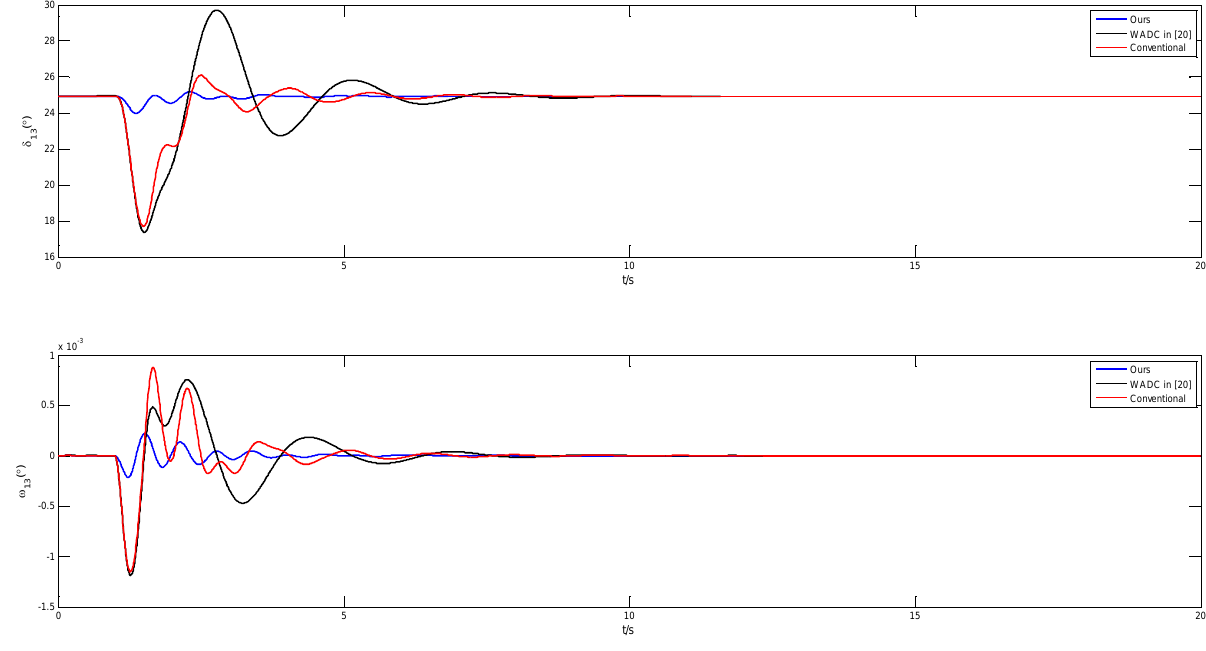
Figure 6. Response of the system in Scenario 2 when 𝜌 = 0 .